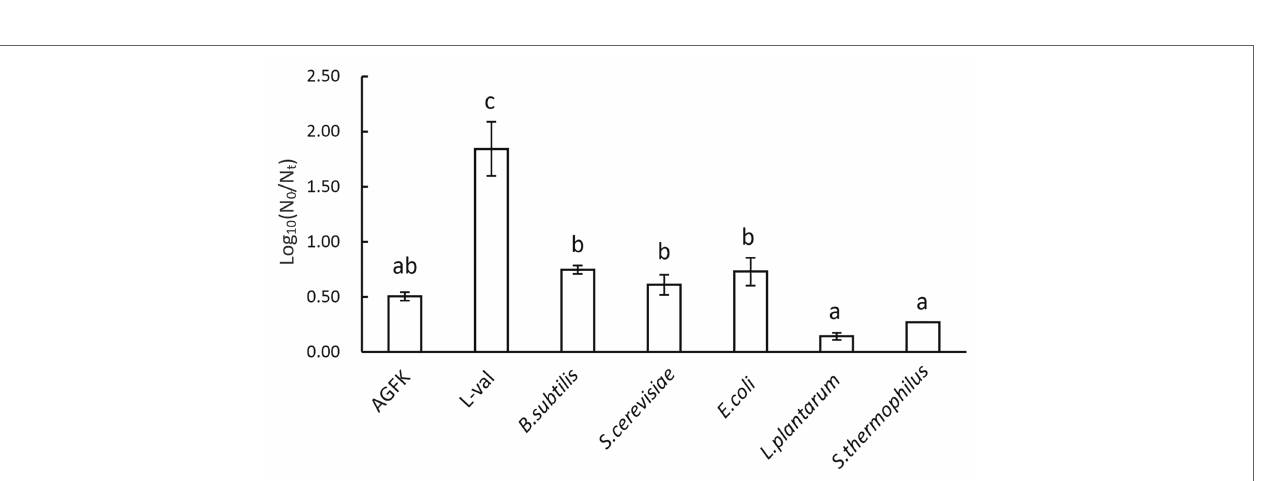
FIGURE 3 | OD 600 detection of wild-type B. subtilis 168 spores with the treatments of various solutions from E. coli , B. subtilis , S. cerevisiae , L. plantarum , and S. thermophiles . (A) The treatment of supernatant from five microorganisms, respectively. (B) The treatment of filterable supernatant from five microorganisms, respectively. (C) The treatment of sediments solution from five microorganisms, respectively. (D) The treatment of ultrasonic sediments solution from five microorganisms, respectively. The treatments of L-val and AGFK were used as the positive control, and untreated spores were control.